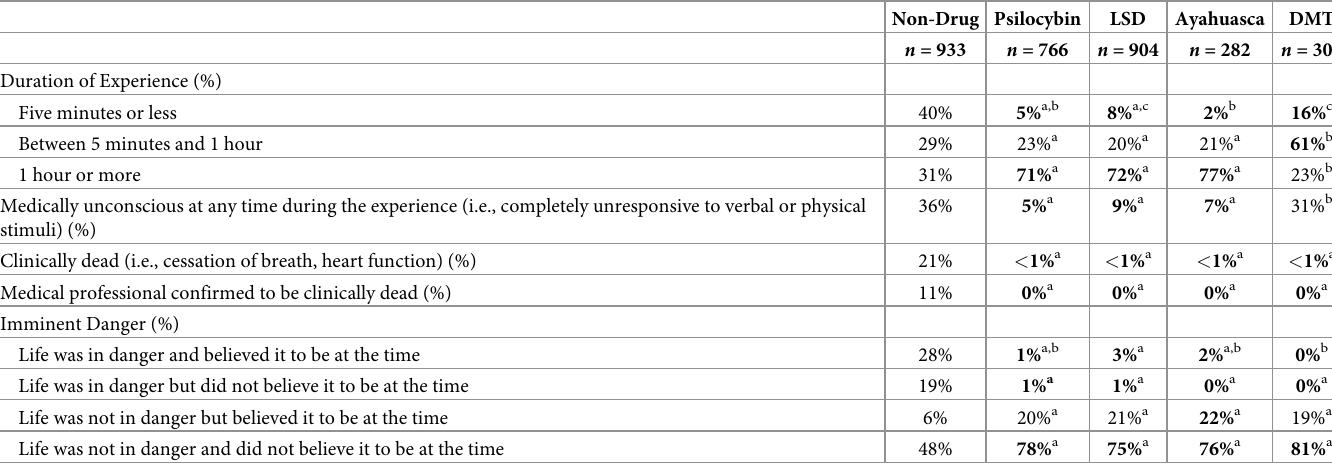
Table 4. Circumstances of the experience in the Non-Drug, Psilocybin, LSD, Ayahuasca, and DMT groups 1,2